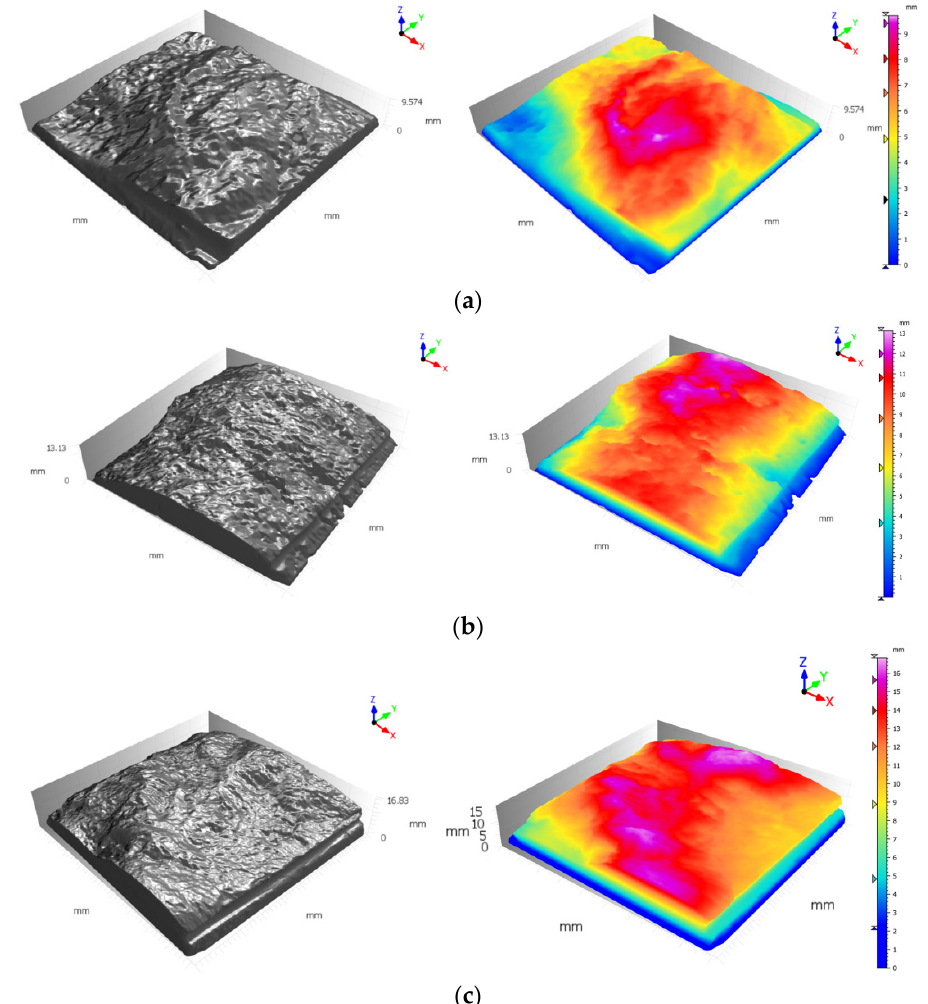
Figure 10. Digitized, 3D scanned of the fabricated rock joints used before the direct shear test ( a ) JRC = 7.8, ( b ) JRC = 12.4, ( c ) JRC = 17.6.